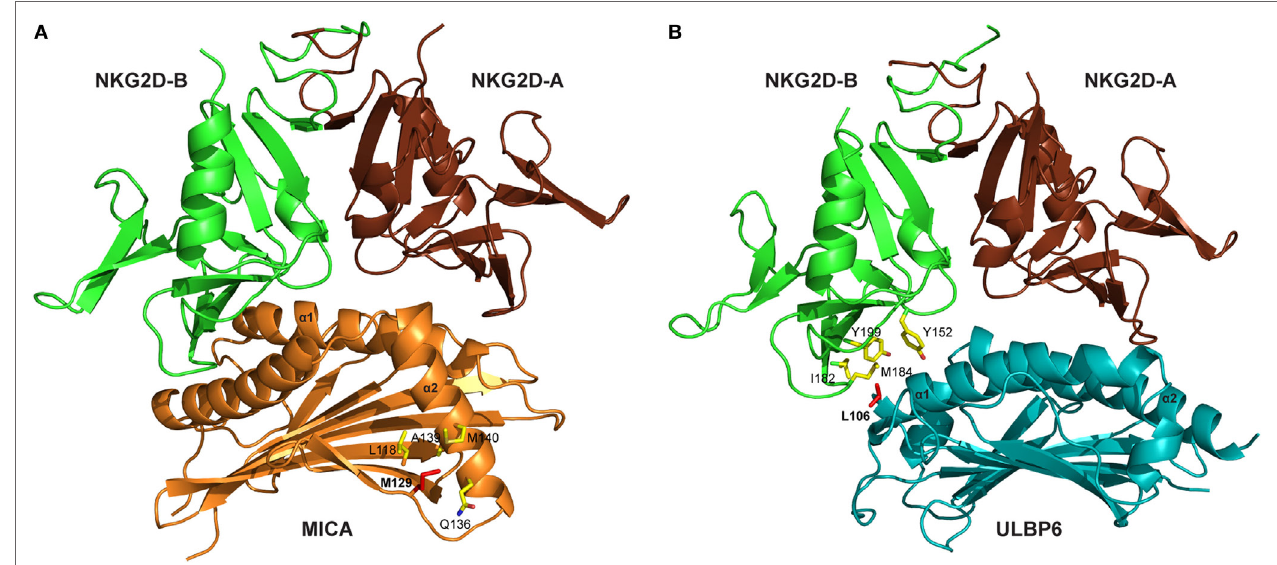
FiGURe 1 | Crystal structures of NKG2D-ligand complexes. (A) Ribbon representation of the MICA–NKG2D complex [PDB code 1HYR, Li et al. (10)]. NKG2D homodimer [NKG2D-A (brown) and NKG2D-B (green)] interacts with the α 1 and α 2 domains of monomeric MICA (orange). The clinically relevant polymorphic residue Met129 (red) in MICA is located distal to the MICA–NKG2D interface. Partially buried Met129 mediates non-polar interactions with MICA residues (ball and stick format) that protrude from the α 2 helix. The α 3 domain of MICA (residues Thr181-Ser274) has been omitted. (B) Ribbon representation of the ULBP6–NKG2D complex [PDB code 4S0U; Zuo et al. (13)]. NKG2D homodimer [NKG2D-A (brown) and NKG2D-B (green)] interacts with the α 1 and α 2 domains of ULBP6 (teal). The disease- associated polymorphic residue Leu106 (red) in ULBP0602 is in close proximity to the ULBP6–NKG2D docking interface, inserting directly into the NKG2D hydrophobic pocket lined by several non-polar residues (ball and stick format). The figure was generated with PyMOL (Molecular Graphics System, Version 2.0 Schrödinger,